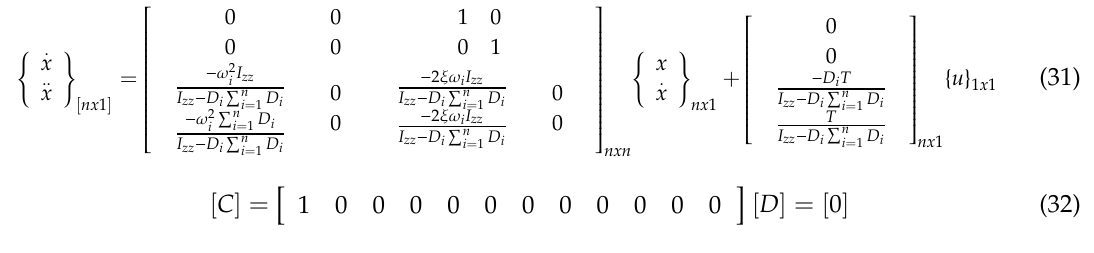
Figure 3. Normalized mode shapes (modal coordinates) displayed in physical coordinates with normalized length on the abscissa in meters and displacements in meters on the ordinant.